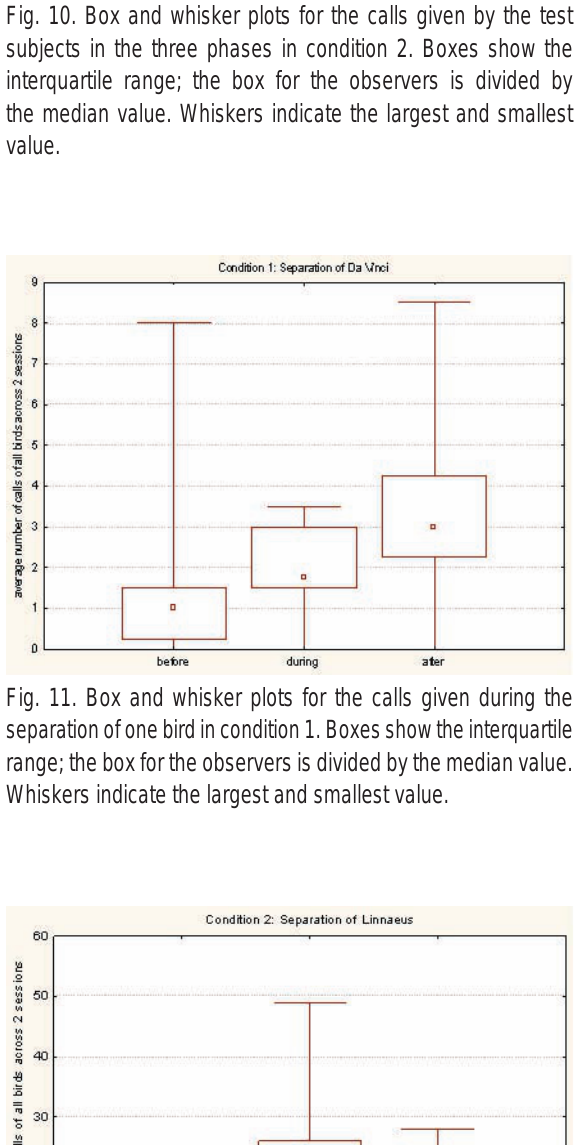
Fig. 12. Box and whisker plots for the calls given during the separation of one bird in condition 2. Boxes show the interquartile range; the box for the observers is divided by the median value. Whiskers indicate the largest and smallest